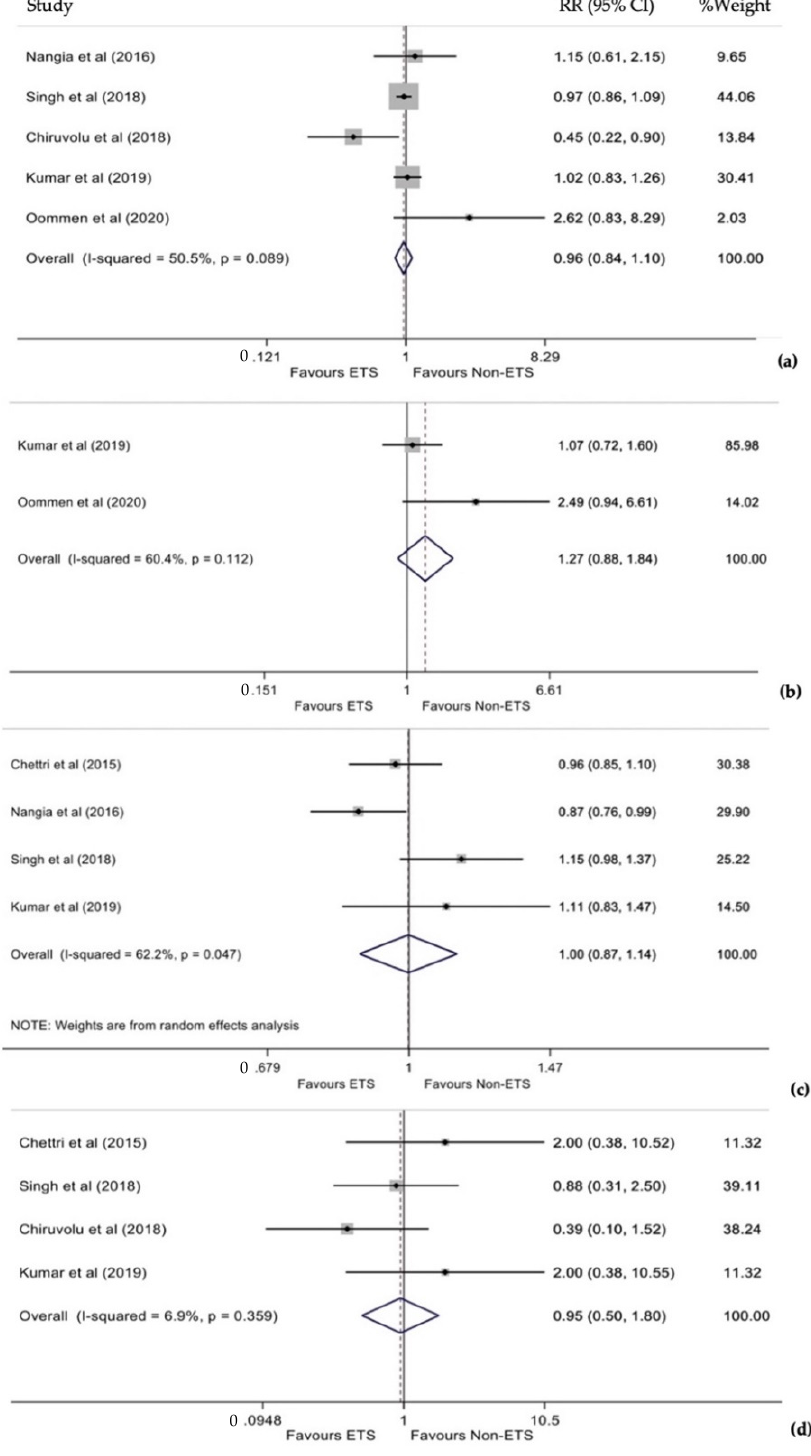
Figure 3. ( a ) Forest plot of RR for respiratory support or mechanical ventilation between ETS and non-ETS. ( b ) Forest plot of RR for TTN between ETS and non-ETS. ( c ) Forest plot of RR for PPV between ETS and non-ETS. ( d ) Forest plot of RR for PPHN between ETS and